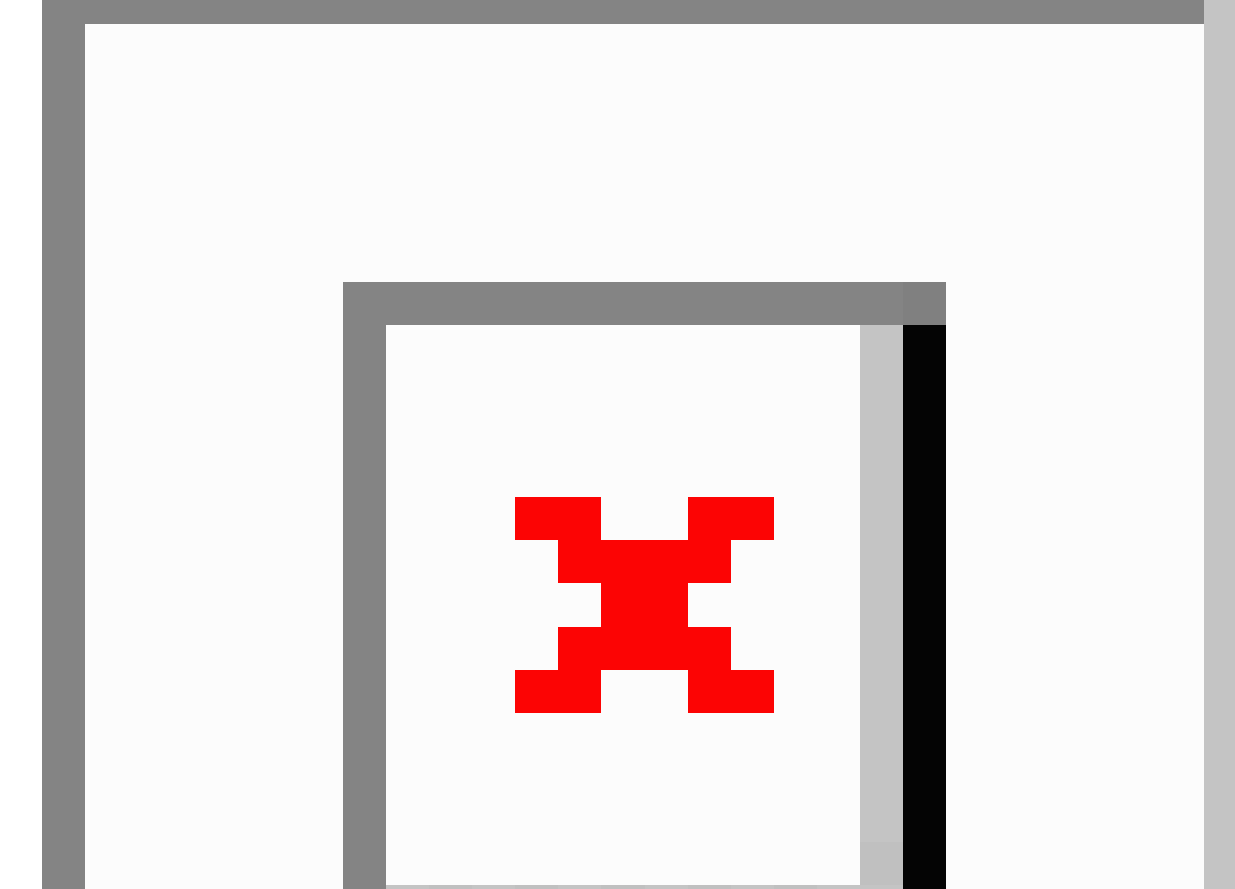
Figure 1. Procedures in the simulation for the intervention and control groups. Boxes with a gray background show intervention-specific components. Duration is in minutes and